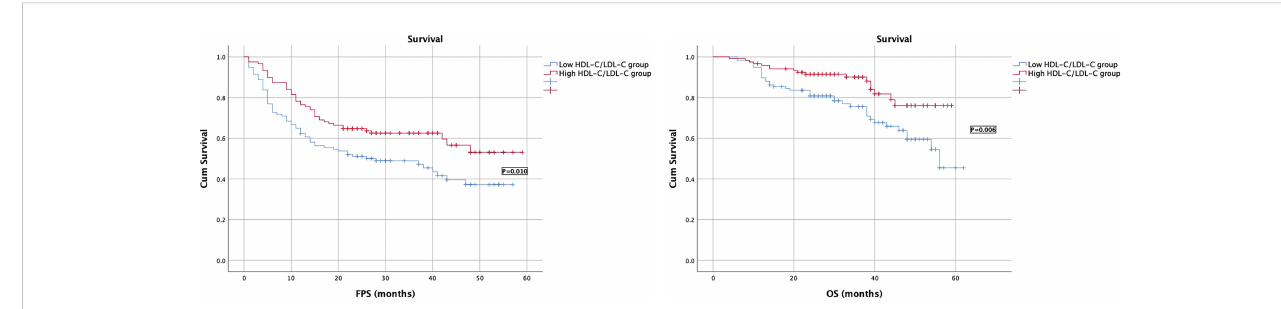
FIGURE 3 Survival curves of PFS and OS in EOC patients in low/high HDL-C/LDL-C